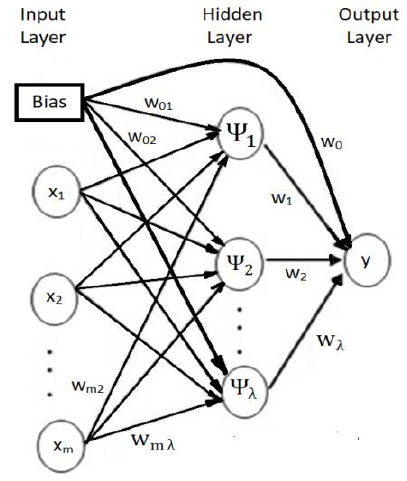
Figure 4. Wavelet-ANN ( x 1 , . . . , x m are the input